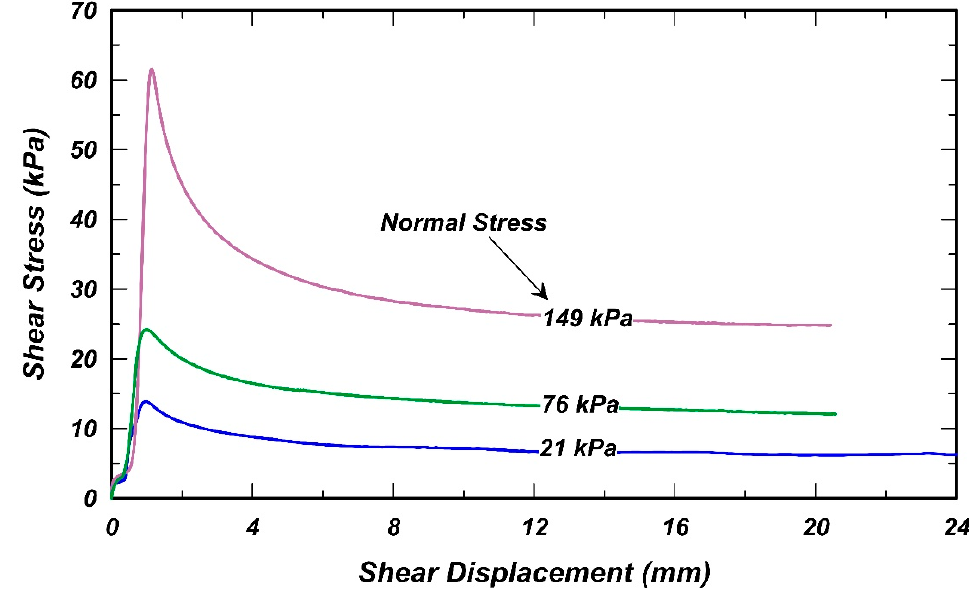
Figure 6. Shear stress versus displacement curves for three ring shear tests performed at normal stresses of 21, 76 and 149 kPa, respectively.